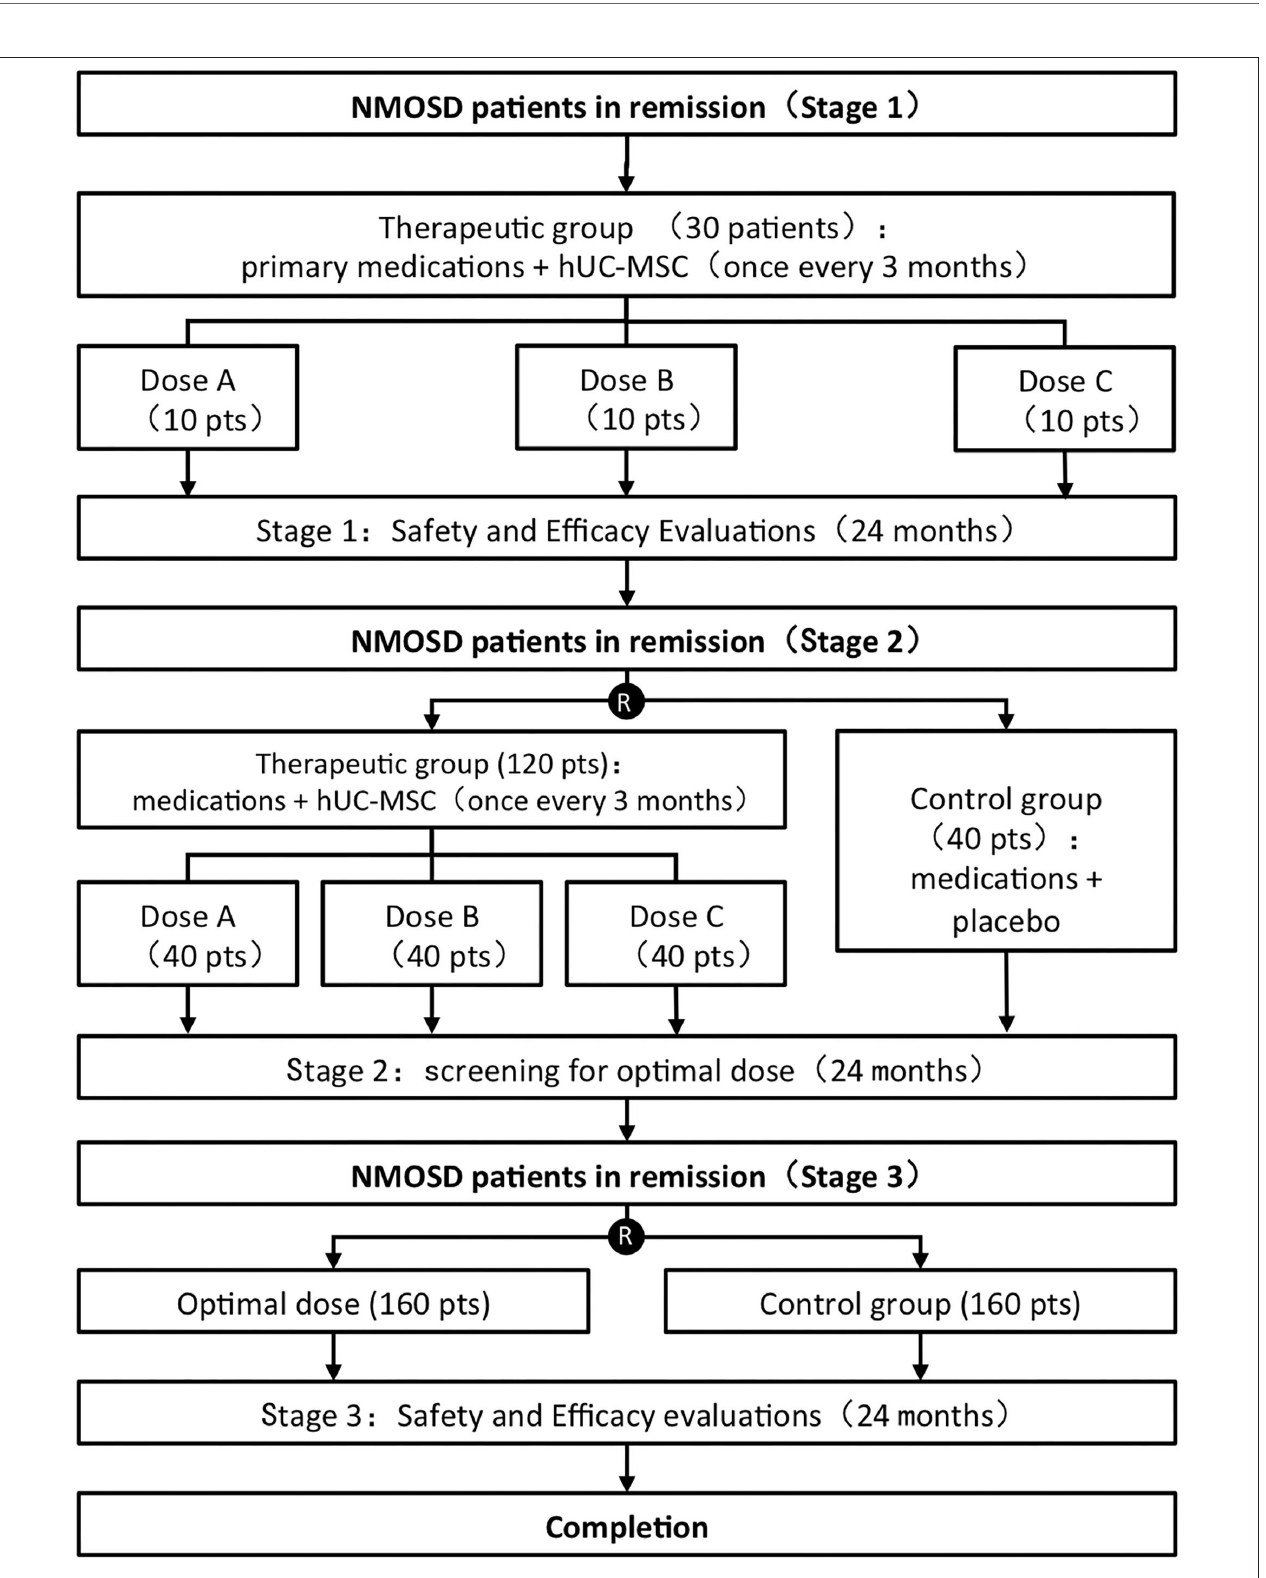
FIGURE 1 | Study flow chart of human umbilical cord mesenchymal stem cells to treat neuromyelitis optica spectrum disorder (hUC-MSC-NMOSD) study.